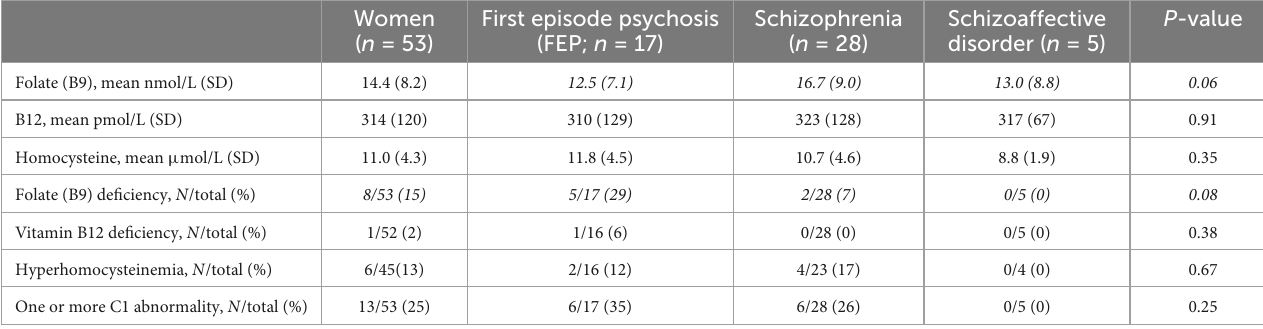
TABLE 4 Biological characteristics according to diagnosis in women.